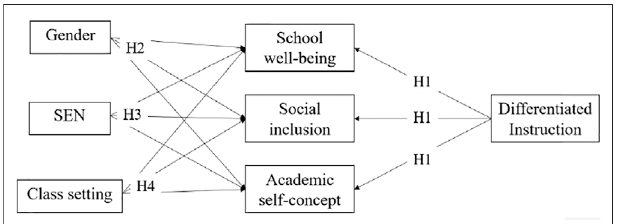
FIGURE 1 | Study ’ s research